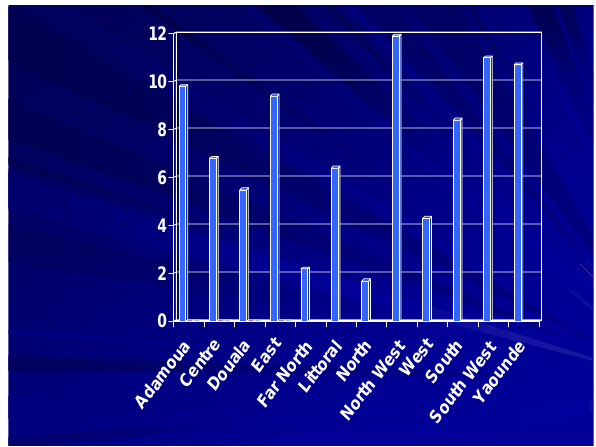
Figure 2: Prevalence of HIV infection in Cameroonian women, by province (Source DHS,